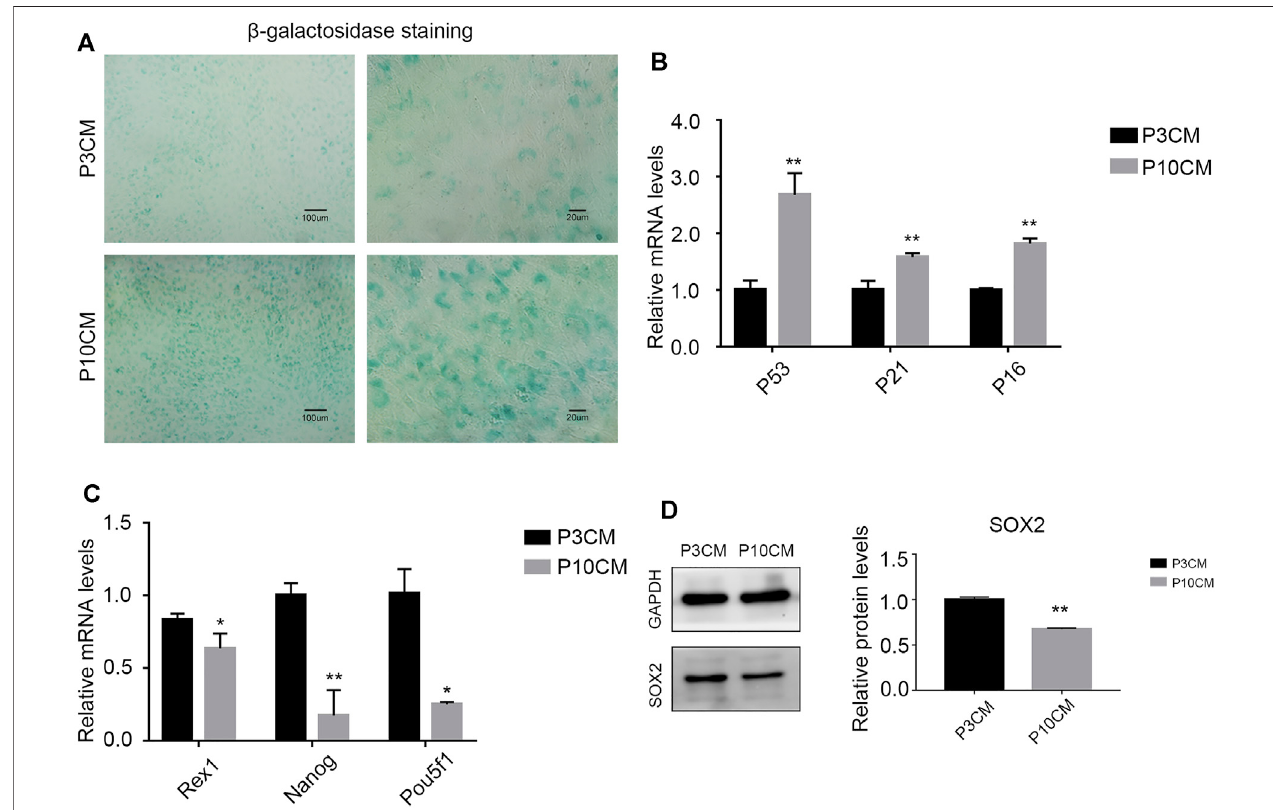
FIGURE 3 | CM from the senescent MSCs decreases stemness and triggers senescence in young BMSCs. (A) β -galactosidase staining of the BMSCs cultured with P3 CM or P10 CM. (Magni fi cation: × 100, scale bar: 100 μ m; magni fi cation: × 400, scale bar: 20 µm). (B) Real-time PCR results showing the expressions of P53, P21, and P16 and other aging-related indicators ( n = 3, **, and p < 0.01). (C) Real-time PCR results showing the expression of the stemness-related indicators Rex1, Nanog, and Pou5f1 ( n = 3, * p < 0.05, and **, p < 0.01). (D) Western blot analysis veri fi ed the protein expression level of SOX2, a stemness-related indicator ( n = 3 and ** p <